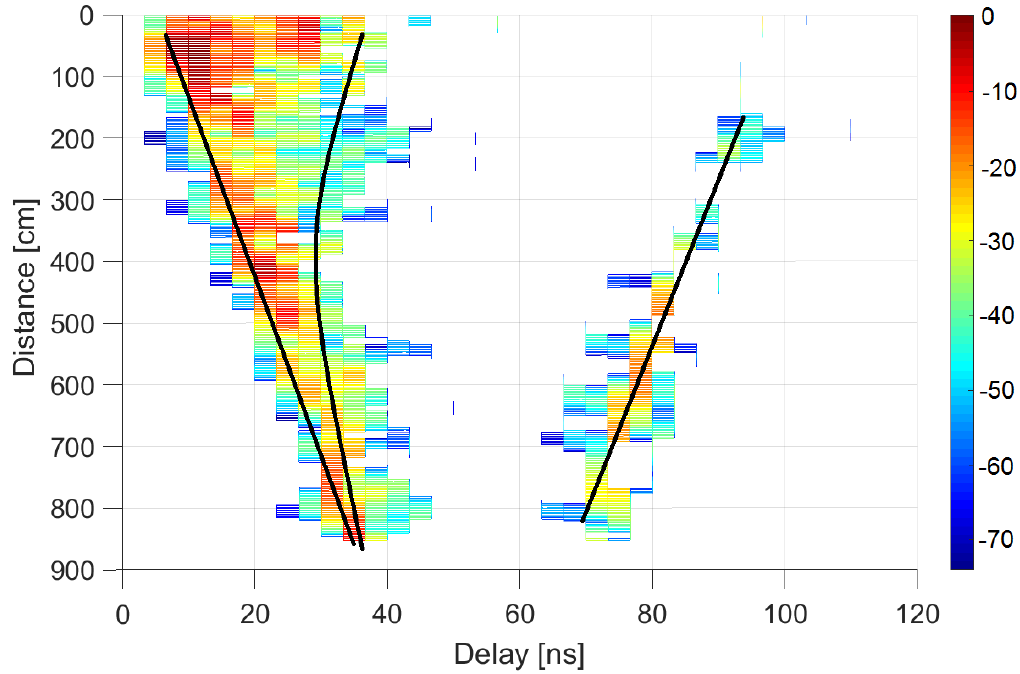
Figure 8. Power delay profile in a corridor under LoS conditions: measurements (in dB relative to maximum) and ray-tracing analysis.